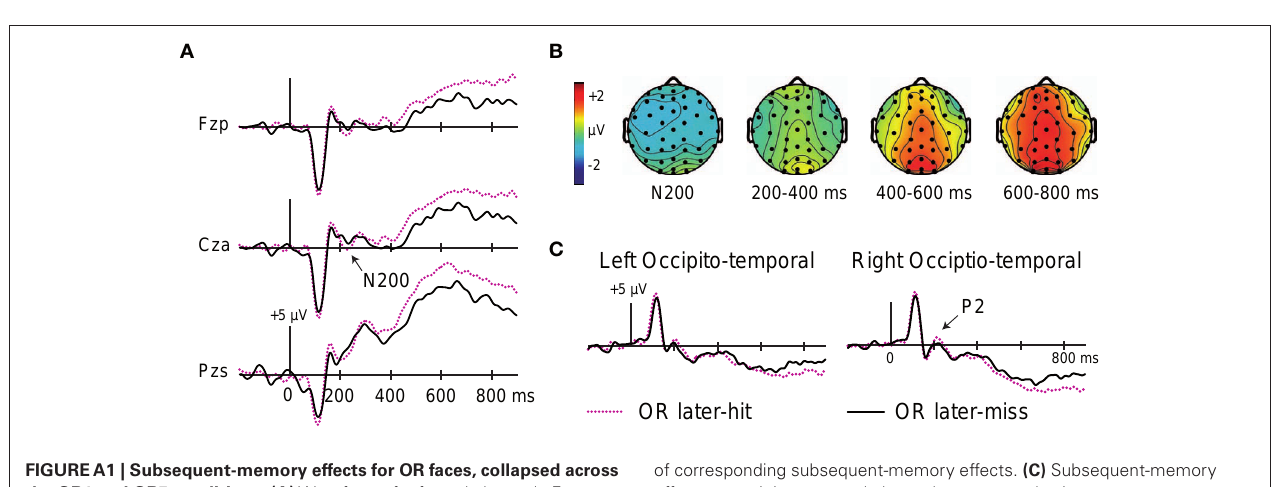
of corresponding subsequent-memory effects. (c) Subsequent-memory effects at occipito-temporal electrodes computed using an average